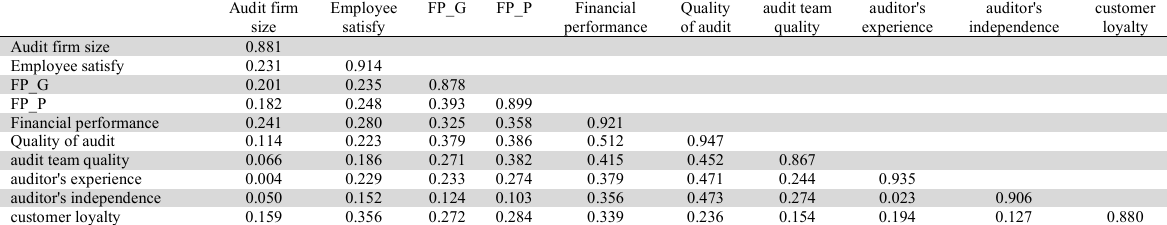
Discriminant Validity (Fornell-Larcker Criterion)